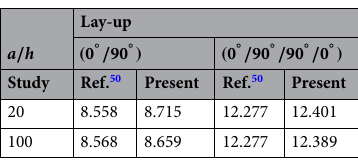
Table 2. Comparison study of non-dimensional natural frequency of a composite plate.